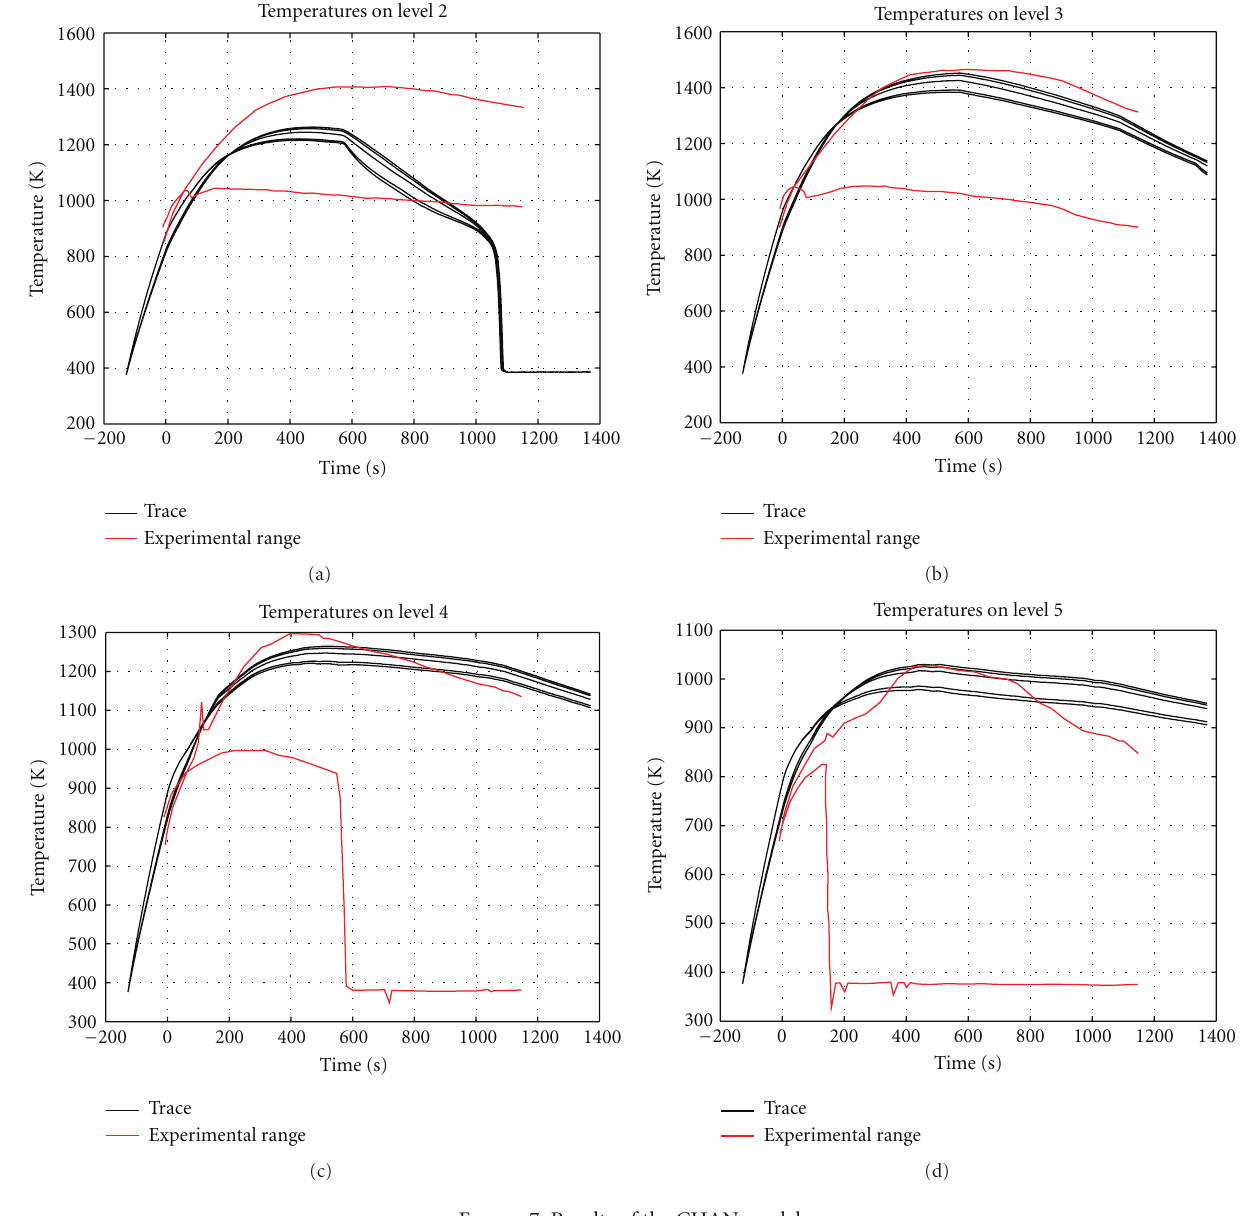
Figure 7: Results of the CHAN